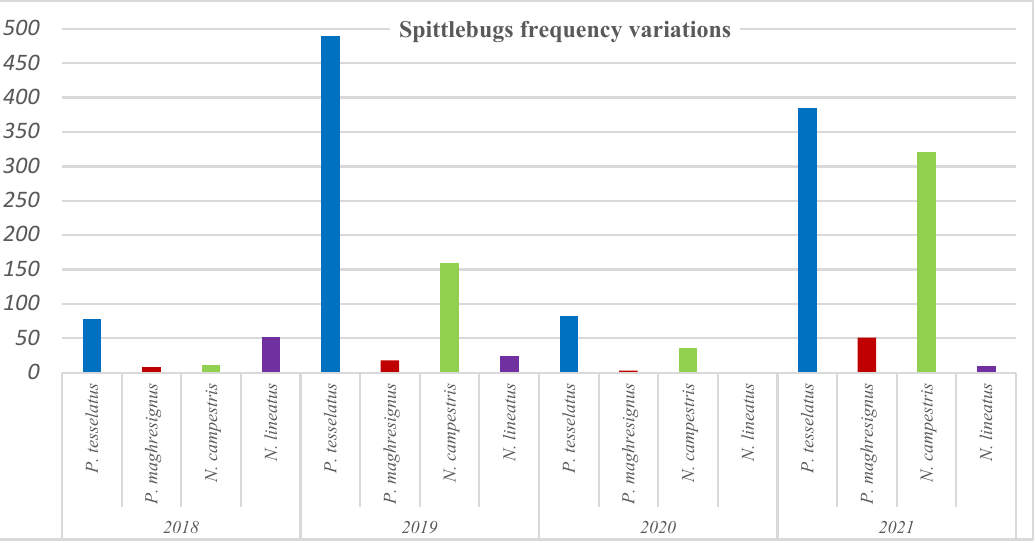
Figure 3. Composition of Aphrophoridae adults in Tunisian regions, 2018–2021. 3.4. Frequency Variations of Aphrophoridae Species According to Year Globally, P. tesselatus was the most abundant species during all the prospected years with highest density in 2019 and 2021. N. campestris is the second most important species (Figure 4).